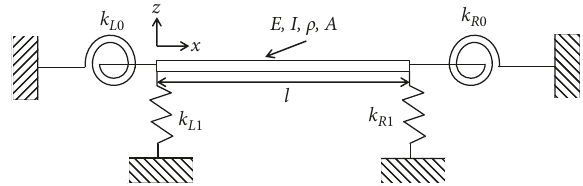
Figure 2: Boundary condition described by rotational and translational flexible